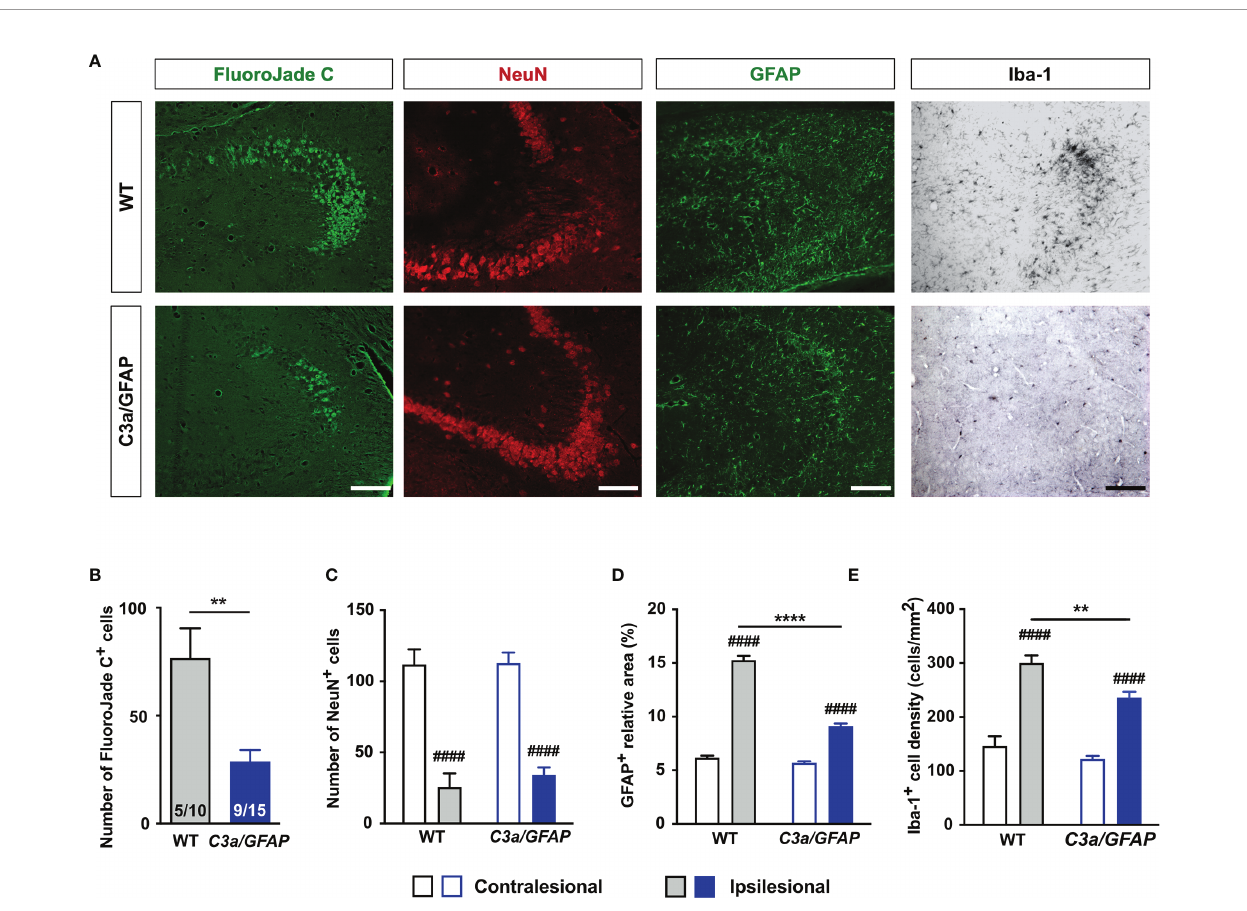
FIGURE 3 | Overexpression of C3a in reactive astrocytes reduces HI-induced neurodegeneration, astrocyte activation, and microglia proliferation. (A) Representative images of ipsilesional CA3 stained with FJC and antibodies against NeuN, GFAP and Iba-1 3 weeks after HI induction. Scale bar = 50 µm. (B – D) Number of FJC + cells (B) and NeuN + cells (C) , relative GFAP + area (D) , and density of Iba-1 + cells (E) in CA3 of WT and C3a/GFAP mice. IL, ipsilesional; CL, contralesional. ** P < 0.005, **** P < 0.0005 vs WT; #### P < 0.0005 vs contralesional. Data were analyzed by two-tailed unpaired t test (B) or two-way ANOVA and Tukey ’ s posthoc analysis (C – E) . Numbers in bars (B) are number of positive mice/total number of mice. (C – E) n = 7 – 9 (WT) and 11 – 14 ( C3a/GFAP ). Values are mean ±